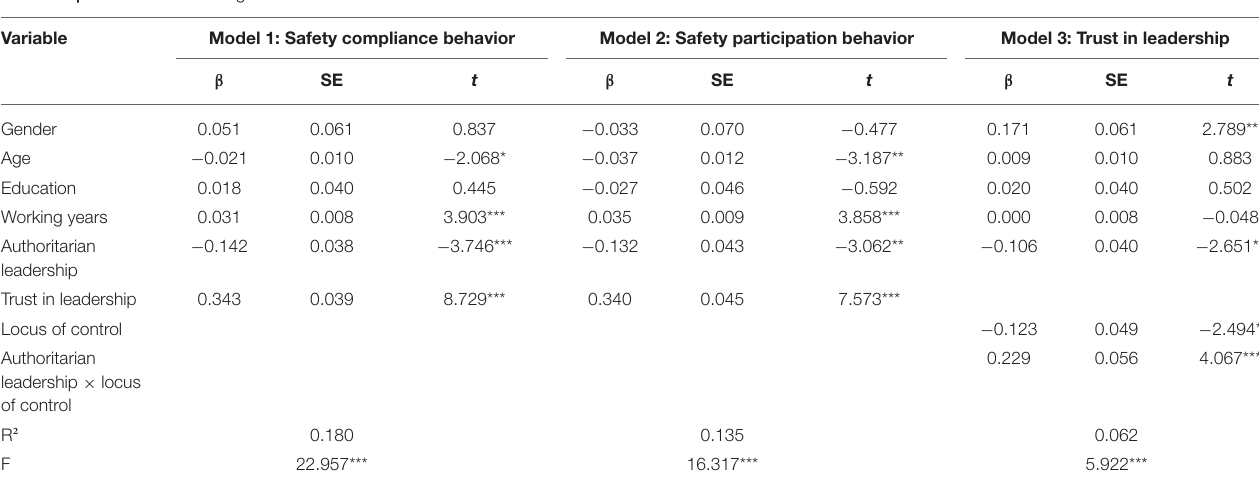
TABLE 5 | Moderated mediating effect.